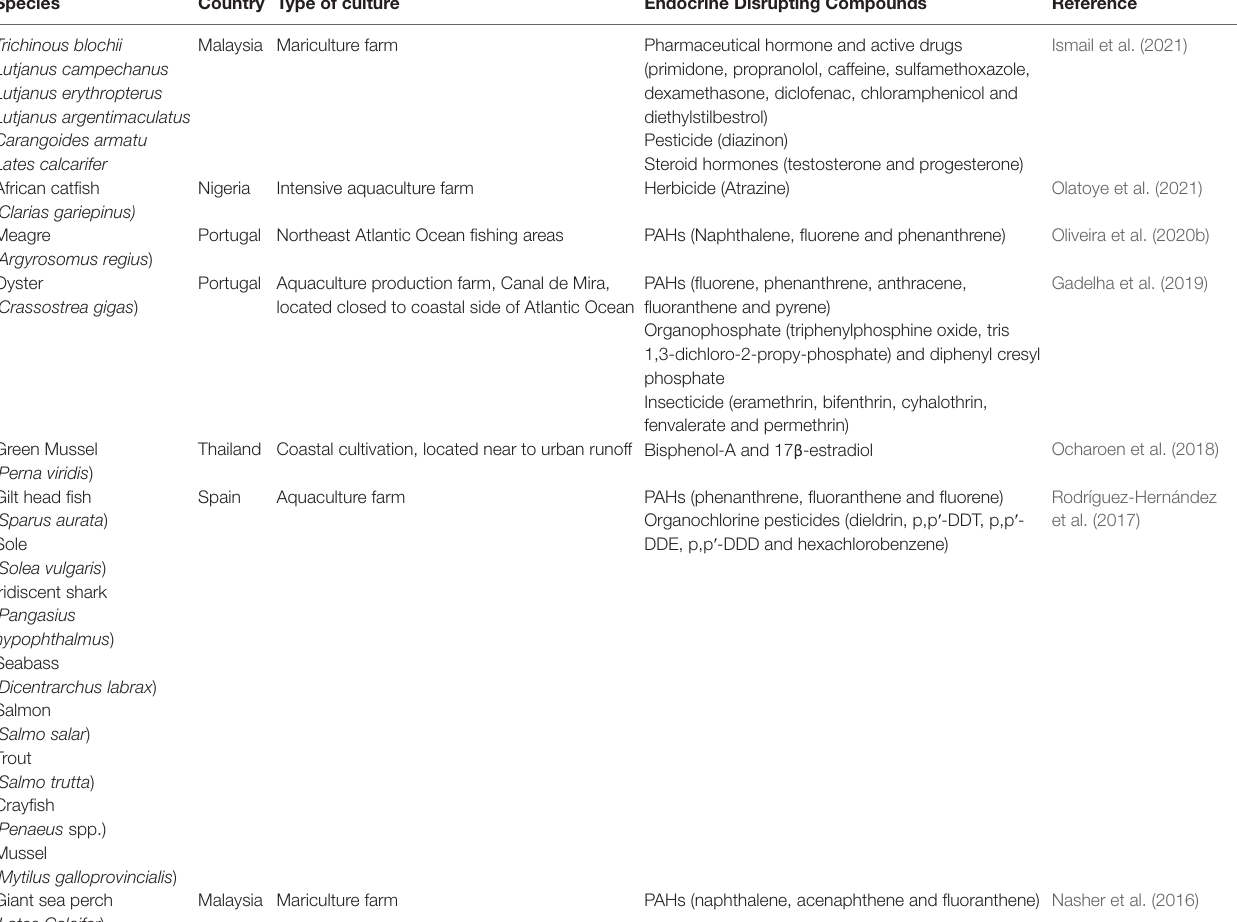
TABLE 3A | Detection of endocrine disrupting compounds in aquaculture organisms.